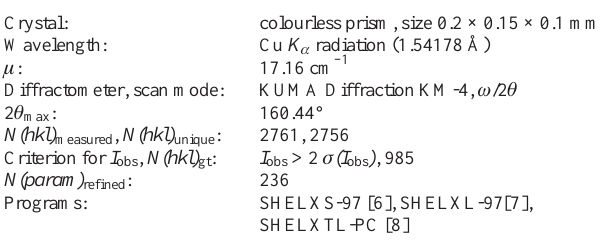
Table 1. Data collection and handling.